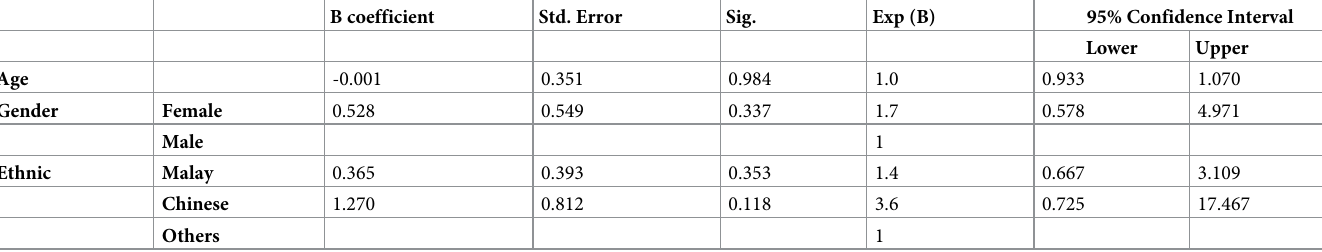
Table 4. Risk factors associated with respiratory virus using Generalized Estimating Equation Logit modeling.